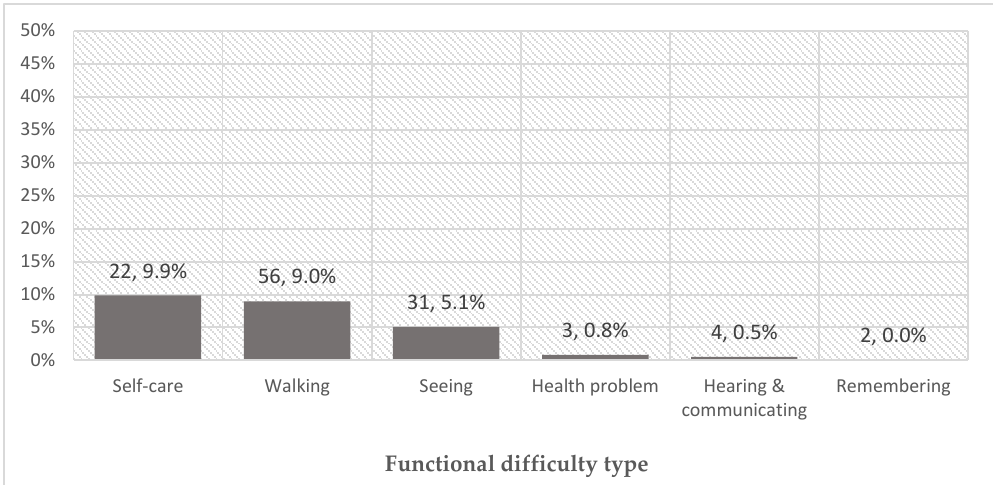
Figure 1. Proportion of population using assistive products (AP) among those who self-reported at least some functional difficulty (number using product, % of people reporting using AP to mitigate a difficulty in that domain); reflects use of products in more than one domain ( n = 6). Table 2. Factors associated with the use of assistive products.